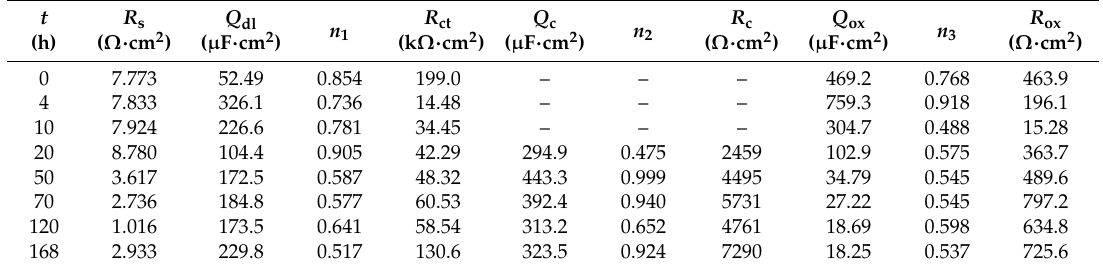
Table 1. Fitting parameters for EIS spectra of 304 SS under polarization at − 0.80 V.